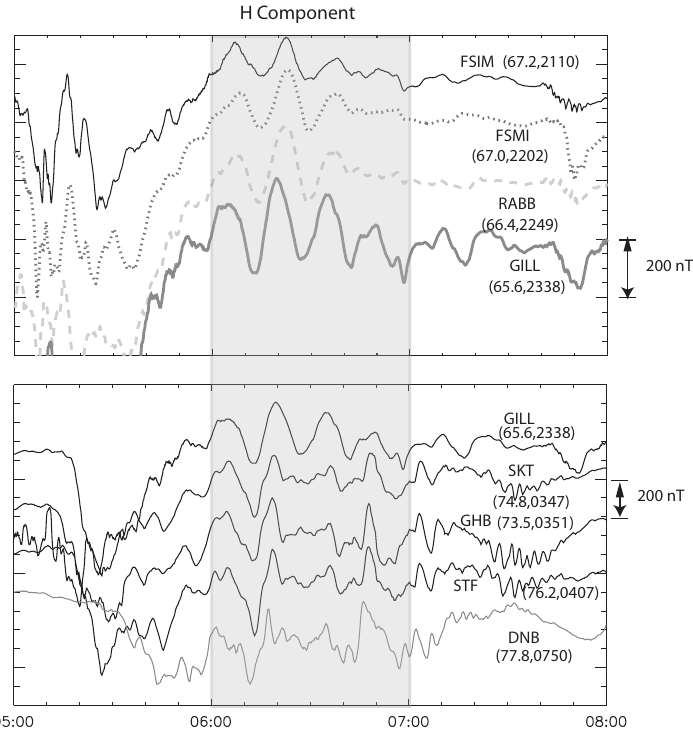
Fig. 12. Part of the ground-based 1.1-mHz pulsations in longitudinal order. Notice the westward propagation of the 1.1-mHz waves.